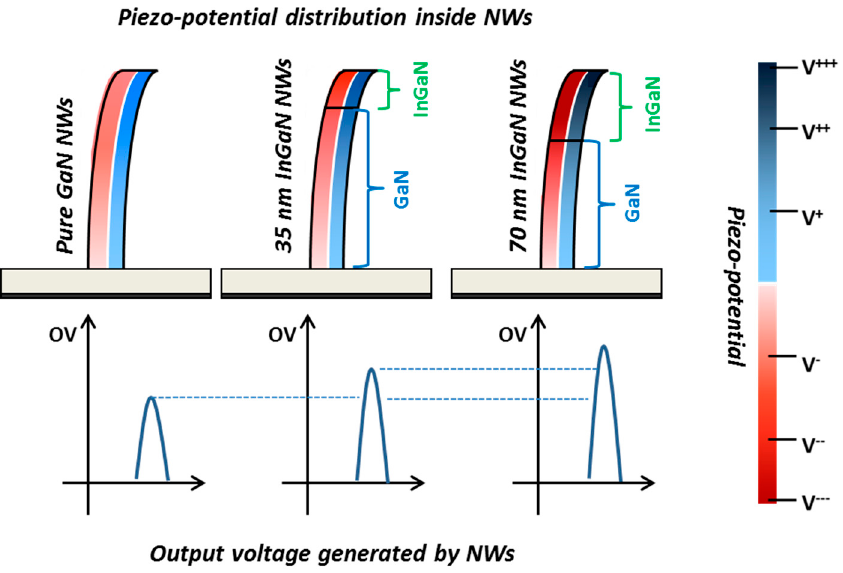
Figure 5. Schematization of the piezo-potential distribution as a function of the NW hetero-structuration and the corresponding output voltage generated for binary GaN NWs ( left side ), 35 nm-thick InGaN/GaN NWs ( middle ) and 70 nm-thick InGaN/GaN NWs ( right side ). The thicker is the InGaN insertion, the higher is the piezo-potential and the larger is the output voltage.